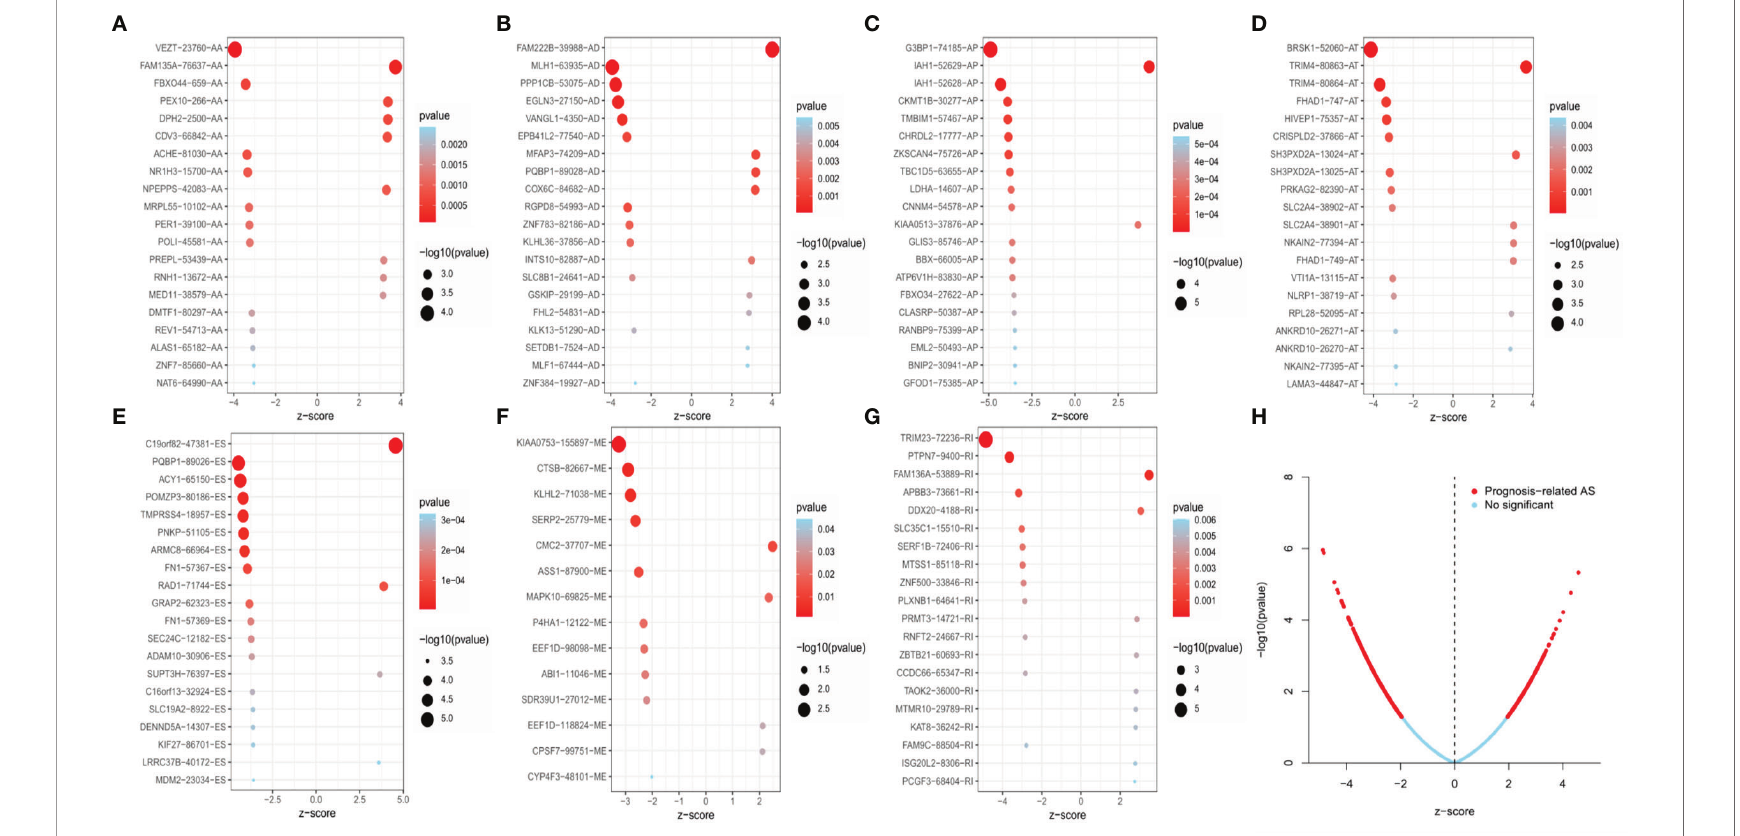
FIGURE 2 | The 20 most relevant prognostic AS events in different types of AS events, except for ME, which had only 14 survival-related AS events (A – G) . Volcano plots showed the AS events with (red color) and without (blue color) signi fi cant relation with the overall survival (OS) of EC patients (H)